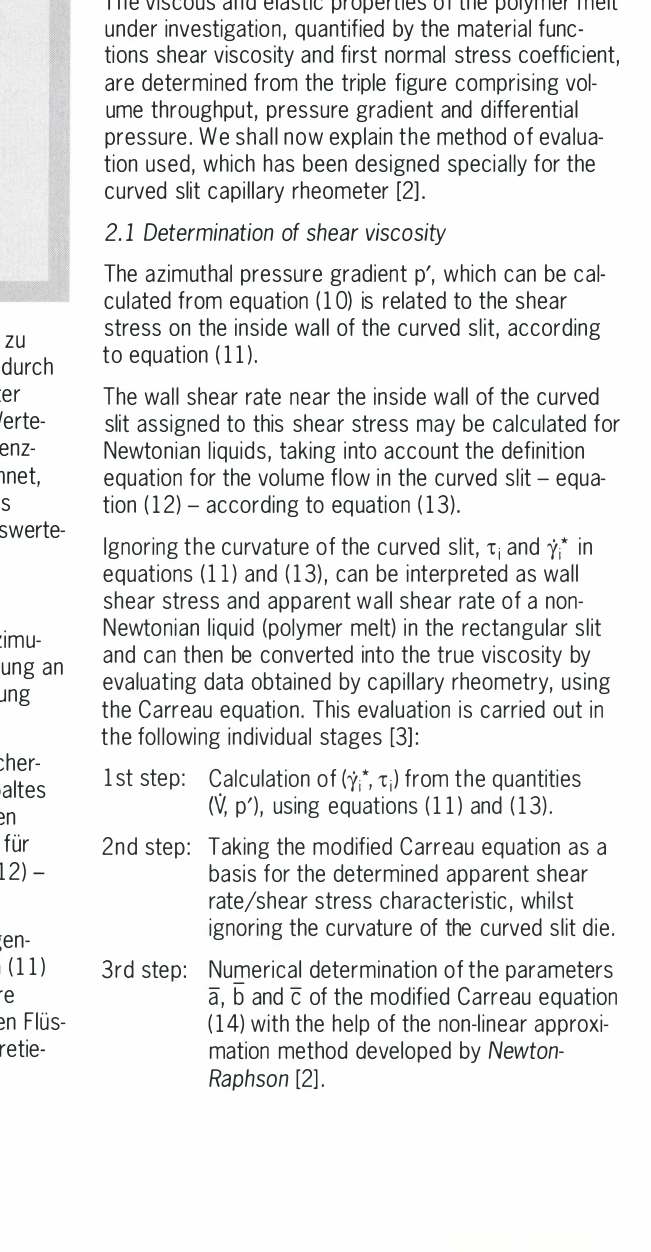
Fig. 2: State of stress in a volume element of a viscoelastic fluid in stationary shear flows with curved